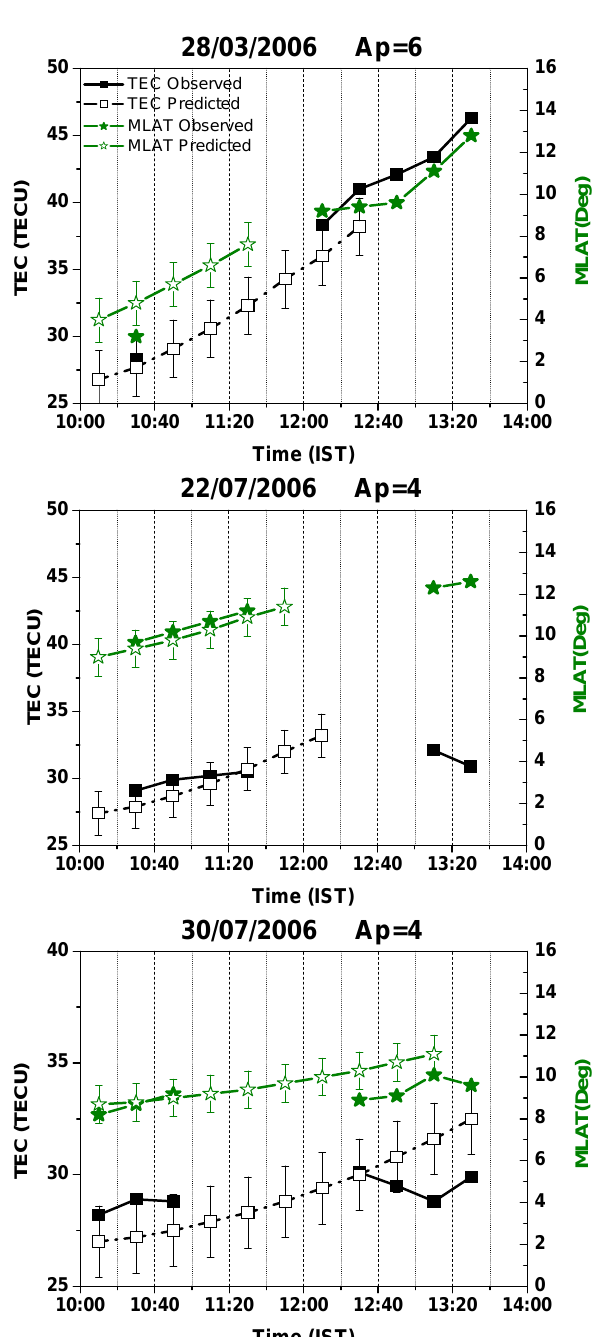
Fig. 7. Same as Fig. 5 but for those days, which are not gone in to the time delay